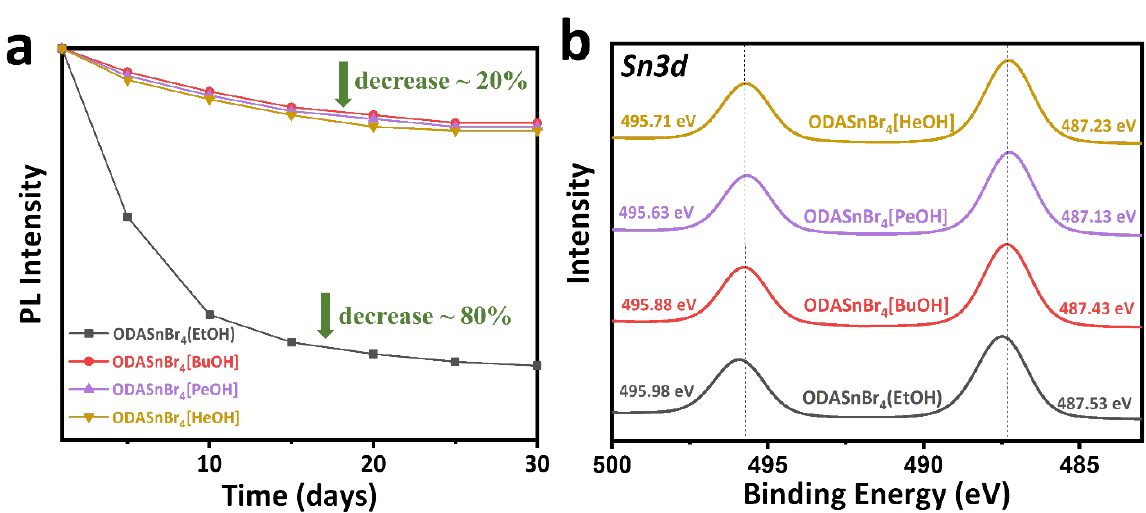
Figure 4. ( a ) Change of PL intensity and ( b ) XPS spectra of the Sn3d core level of ODASnBr 4 (EtOH), ODASnBr 4 [BuOH], ODASnBr 4 [PeOH], and ODASnBr 4 [HeOH] perovskite microcrystals followed for a period of up to 30 days, for the samples stored under ambient conditions in sealed glass vials with humidity above 50% when bottled.